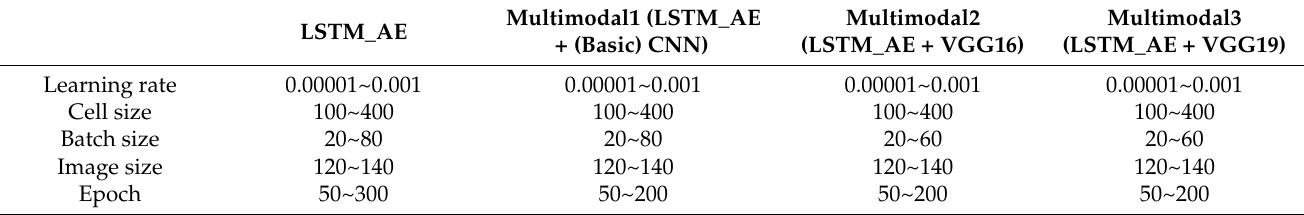
Table 1. The range of hyperparameter settings for each model.